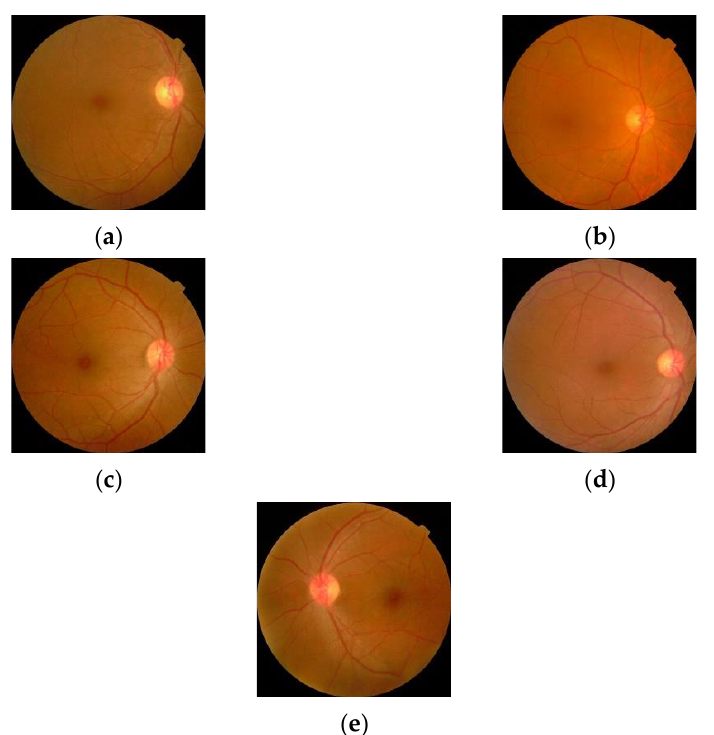
Figure 9. Training images distribution.